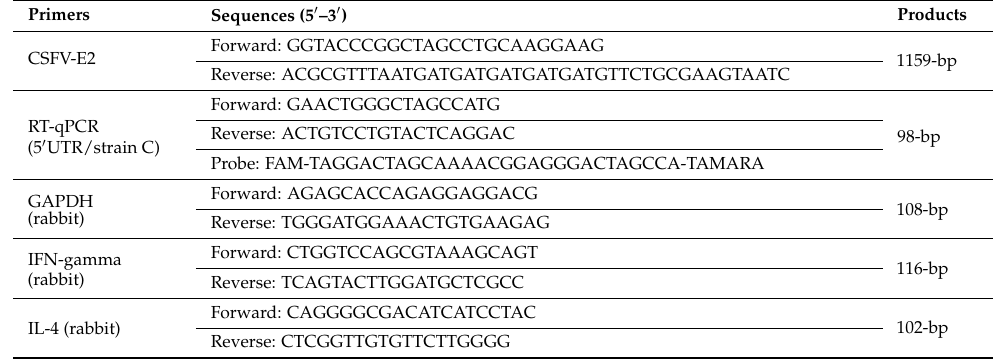
Table 1. Primers for ferritin nanoplatform construction and